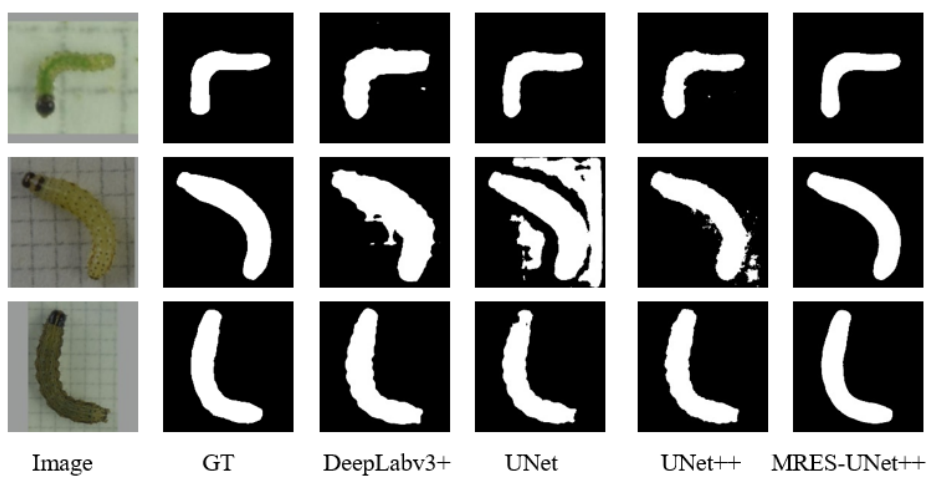
Figure 11. The segmentation results of four models for FAW larvae.